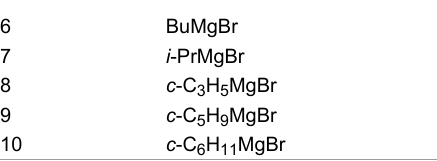
Table 2: Screening of Grignard reagents. a (continued) 6